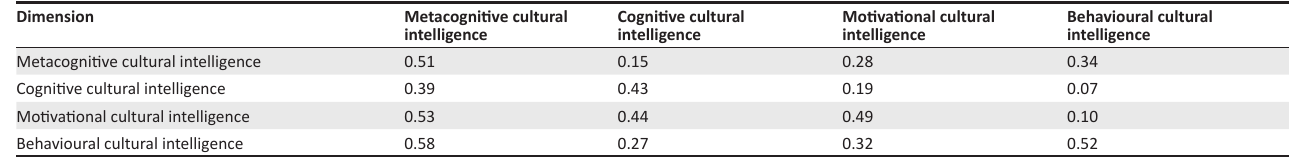
TABLE 4: Inter-correlations between latent cultural intelligence scale dimensions, average variance extracted and shared variance estimates. Dimension